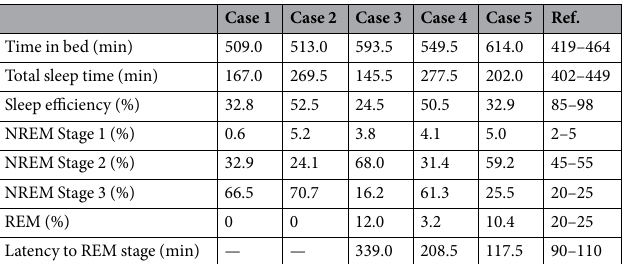
Table 2. Sleep efficiency and sleep organization indices for the five FFI patients. Ref. stands for reference value range; REM: rapid eye movement; NREM: Non- rapid eye